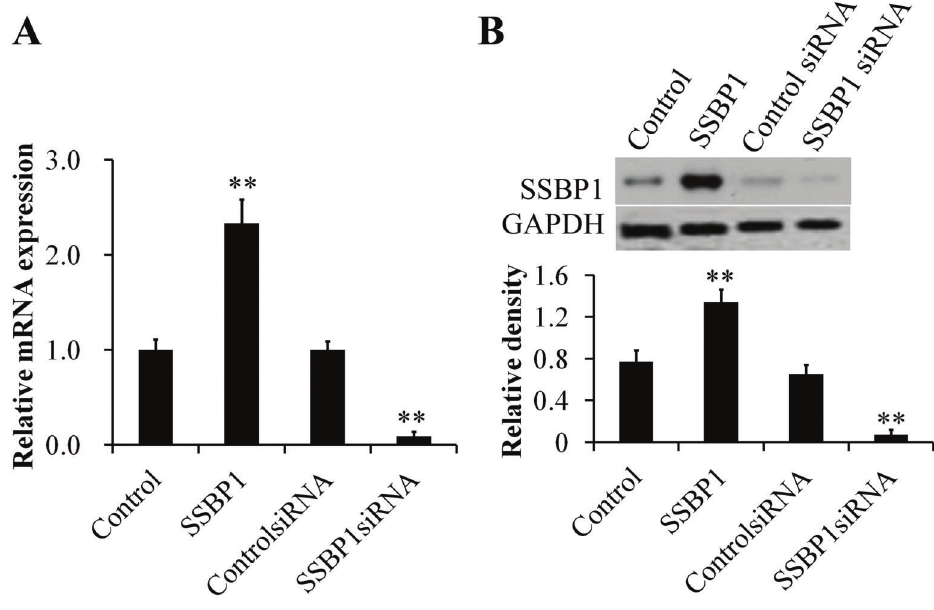
Figure 3. Single-stranded DNA-binding protein (SSBP1)-expression vector or siRNA were transfected into human umbilical vein endothelial cells. A , mRNA expression levels of SSBP1 assayed by real-time PCR. B , Protein expression levels of SSBP1 assayed by western blot. Data are reported as means ± SE, n=4. **P o 0.01 vs control